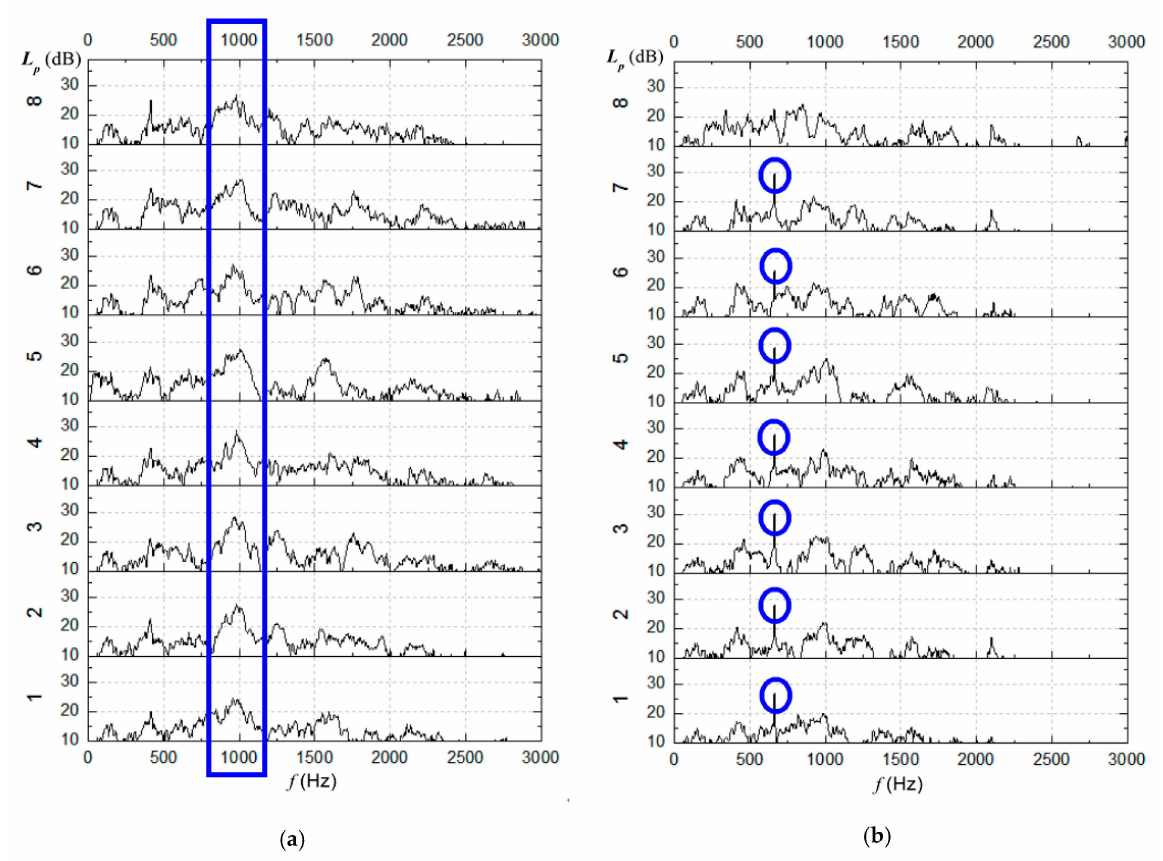
Figure 13. Comparison of outlet-noise spectra of different blade models. ( a ) B—0.132 m 3 /s at 1000 rpm, ( b ) C—0.132 m 3 /s at 1000